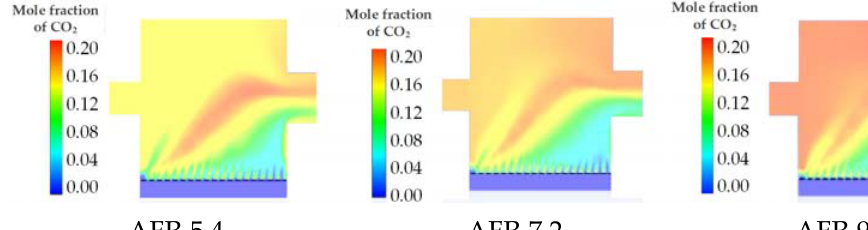
Figure 11. Contours of CO 2 concentration.